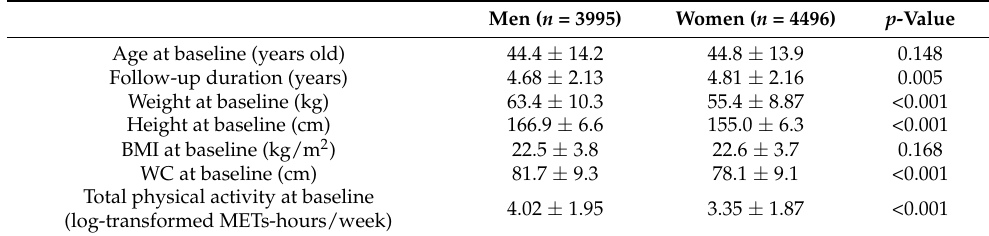
Table 1. General characteristics of participants ( n =